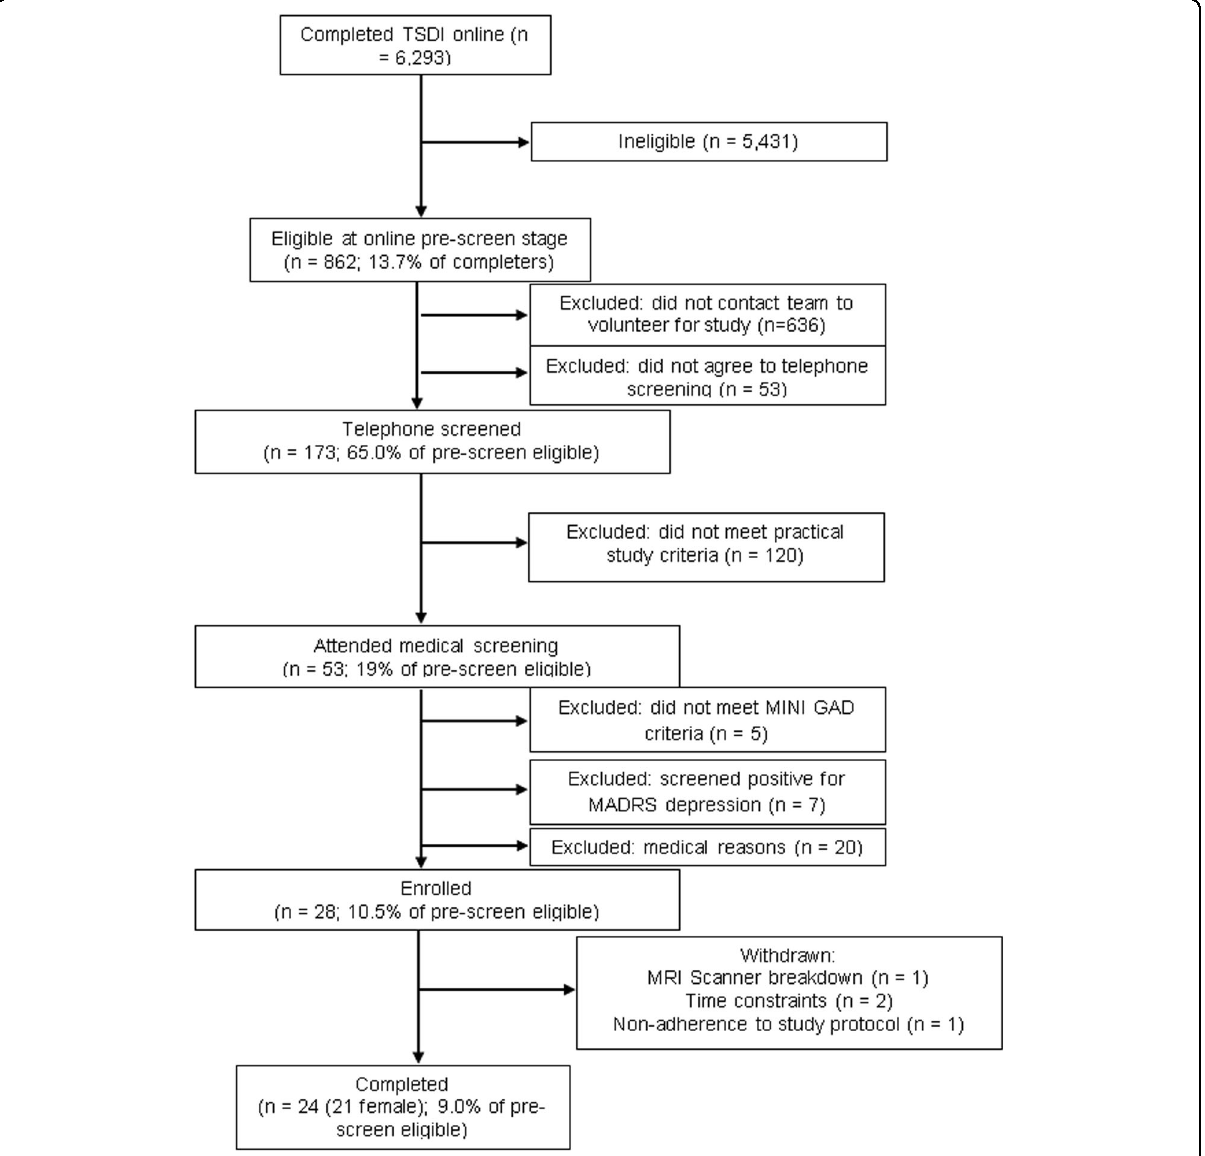
Fig. 2 Flow chart showing the exclusion path and numbers. Abbreviations: TSDI, Trait Self-Description Inventory; MINI, Mini International Neuropsychiatric Interview; GAD, generalised anxiety disorder; MADRS, Montgomery-Asberg Depression Rating Scale; MRI, magnetic resonance